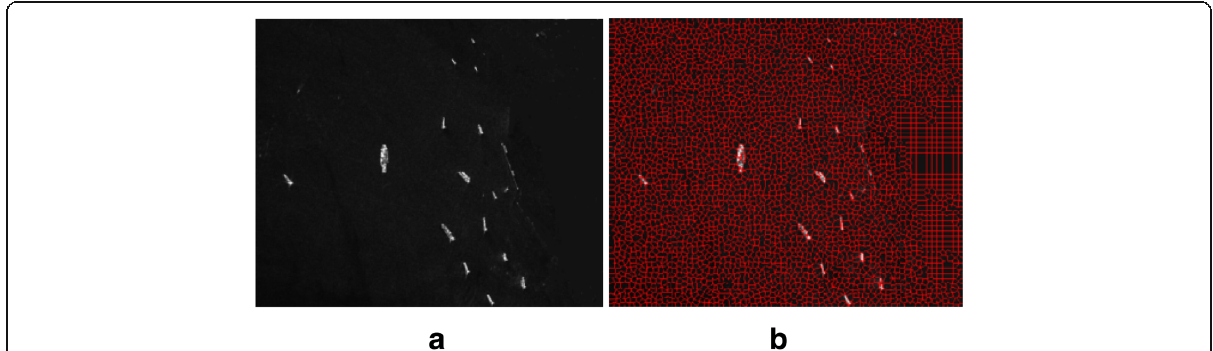
Fig. 4 The superpixel generation result of the original SAR image. a The land shielding result. b Superpixel segmentation result